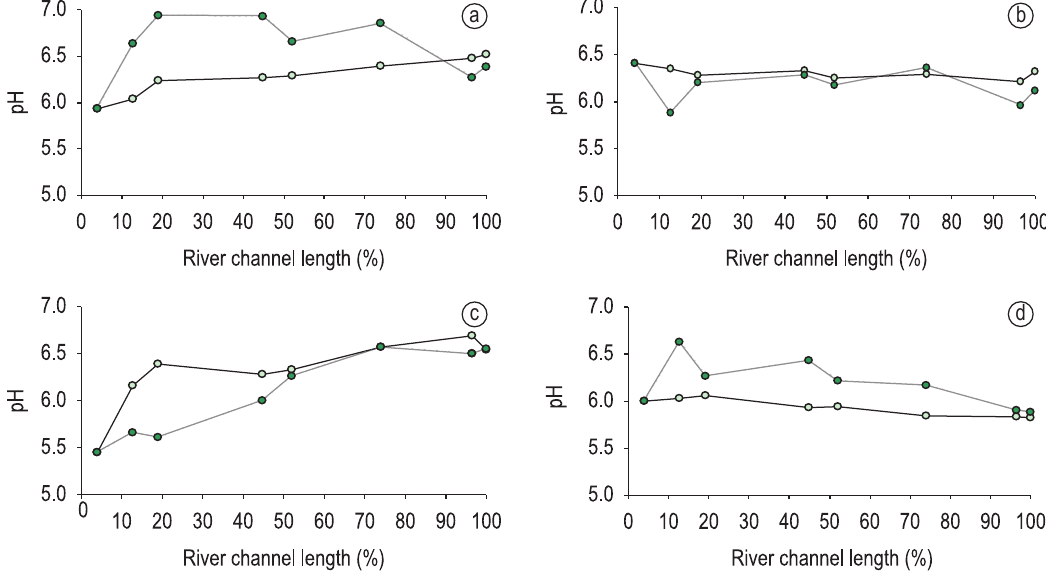
Figure 7. pH variation in Canha River, during the spring (a - September), summer (b - January), autumn (c - April) and winter (d - July) periods periods, respectively. ● : observed pH; “ ● ”: simulated pH.